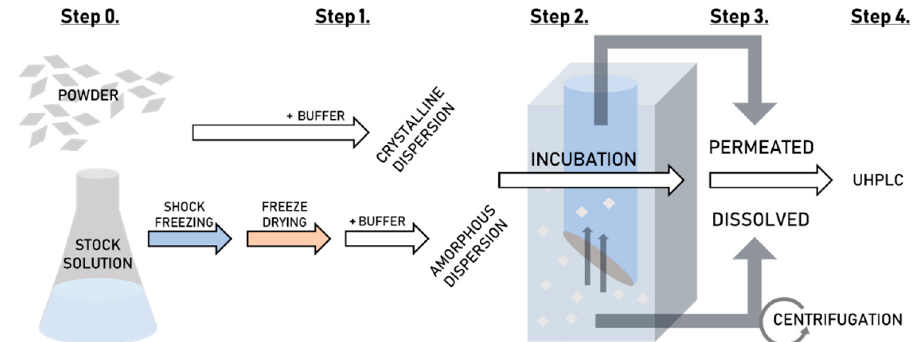
Figure 2. A flow-diagram of the high-throughput dissolution/permeation screening. Step 0. Formulation preparation, Step 1. Dispersion of the formulations, Step 2. Incubation of the two-compartment plate, Step 3. Sampling from the top-plate (acceptor) and bottom-plate (donor) and Step 4. Quantification of tadalafil by UHPLC. Table 2. Overview of all conducted high-throughput dissolution/permeation experiments to evaluate the influence of experimental parameters: 1) acceptor medium; 2) incubation time; and 3) dispersion medium.